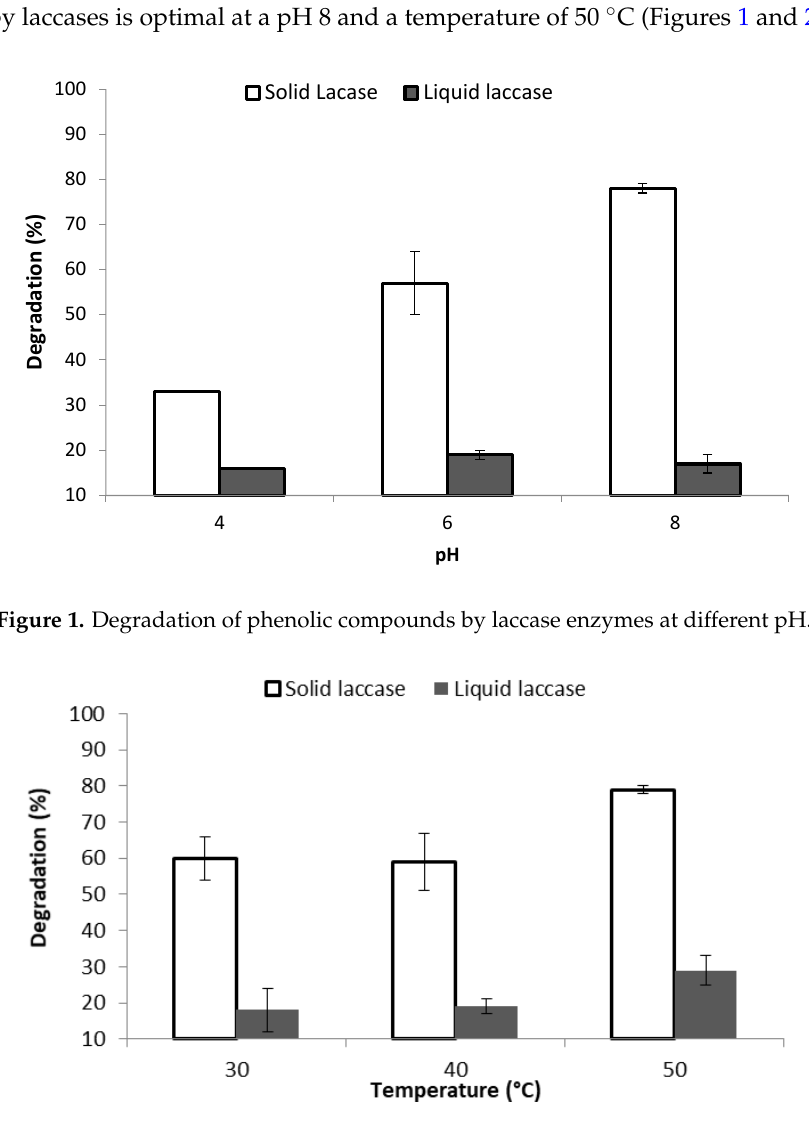
Figure 2. Degradation of phenolic compounds by laccase enzymes at different temperatures.